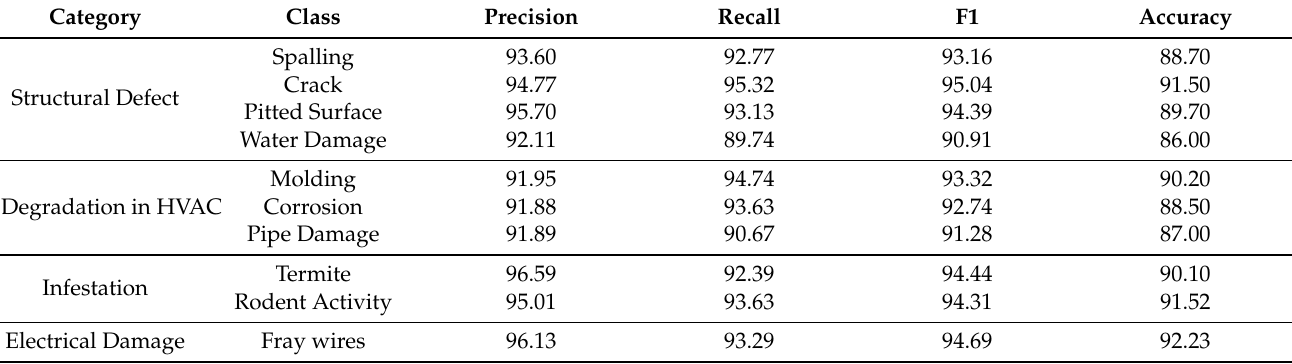
Table 5. Statistical measures for the deterioration detection framework (the proposed